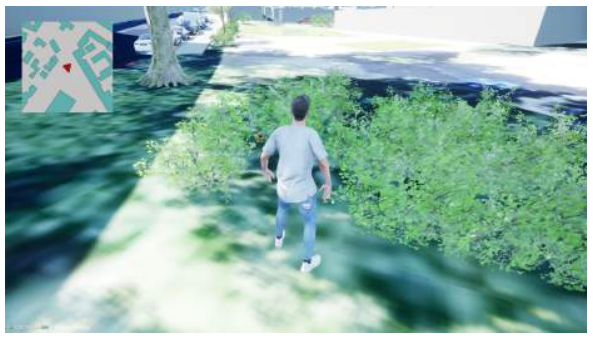
Figure 7. Bird hidden in the Environment